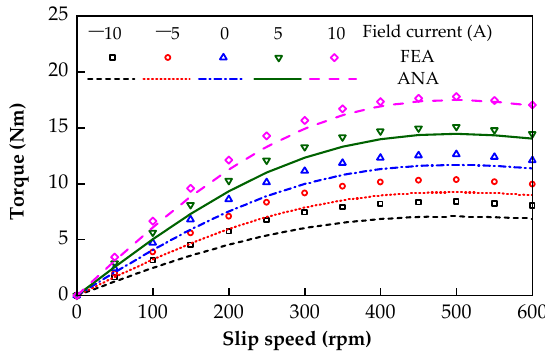
Figure 9. The average eddy current densities under different slip speeds.